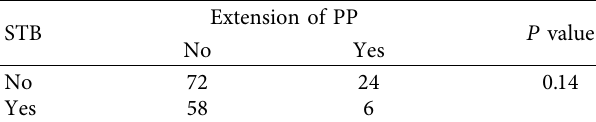
Table 3: The relationship between STB and PP.